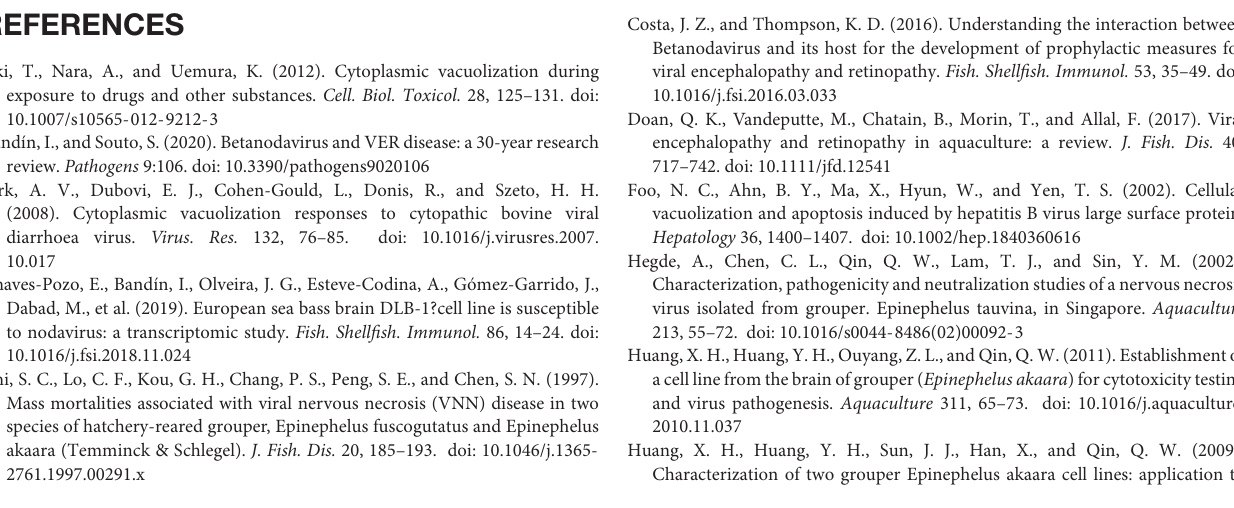
FIGURE S1 | Rab5 and Rab7 localization during RGNNV infection. GS cells were transfected with pEGFP-Rab5 or pEGFP-Rab7, and subsequently infected with RGNNV. At 24 h p.i., the cells were stained with DAPI and the fluorescence was observed via fluorescence